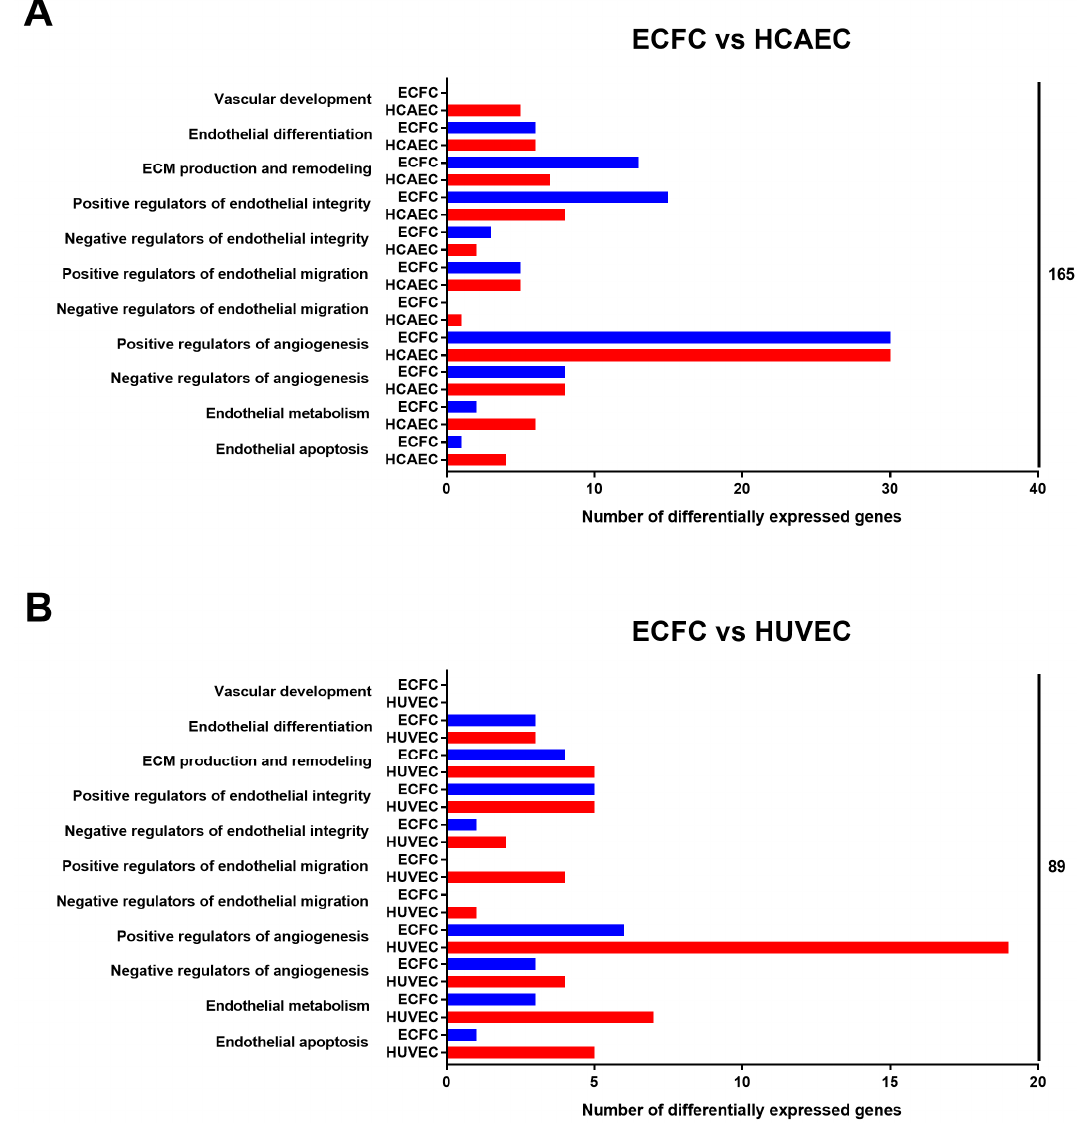
Figure 4. Pairwise comparison of ( A ) ECFC versus HCAEC and ( B ) ECFC versus HUVEC according to the manual annotation of DEGs (only endothelial biology-related categories shown). Total number of DEGs within the indicated categories is provided as the count at the right side of the